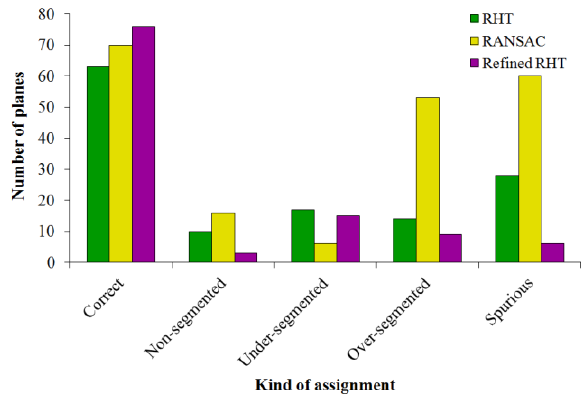
Figure 8. Quality assessment